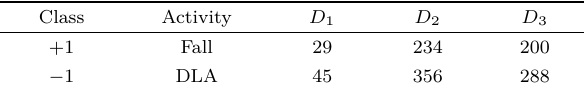
Table 3 Number of fall and DLA activities in each